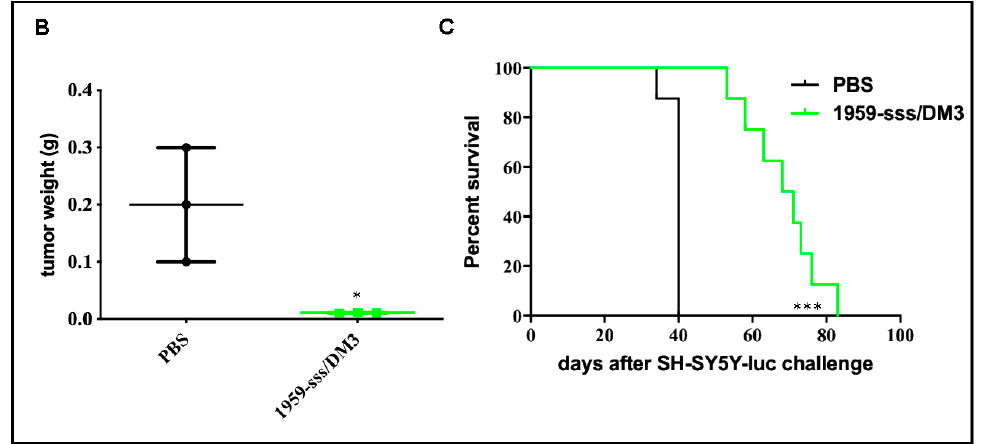
Figure 3. Therapeutic activity of 1959-sss/DM3 in SH-SY5Y-LUC orthotopic xenograft model. ( A ) Orthotopic SH-SY5Y-LUC neuroblastoma xenograft showing potent antitumor activity of intravenous 1959-sss/DM3 administration (arrows) at the dose of 10 mg/kg twice weekly. Growth curve obtained was expressed as tumor region of interest (ROI). In the below panels, single animals ROI are shown. Unpaired T Test. * p = 0.01; *** p < 0.0001. ( B ) Tumor weight of animals sacrificed 24 h after the last treatment. Unpaired T Test. * p = 0.03. ( C ) Survival curves evaluated by Kaplan-Meier and analyzed by Log-rank (Mantel-Cox). *** p = 0.0001. n.s. (not significant).